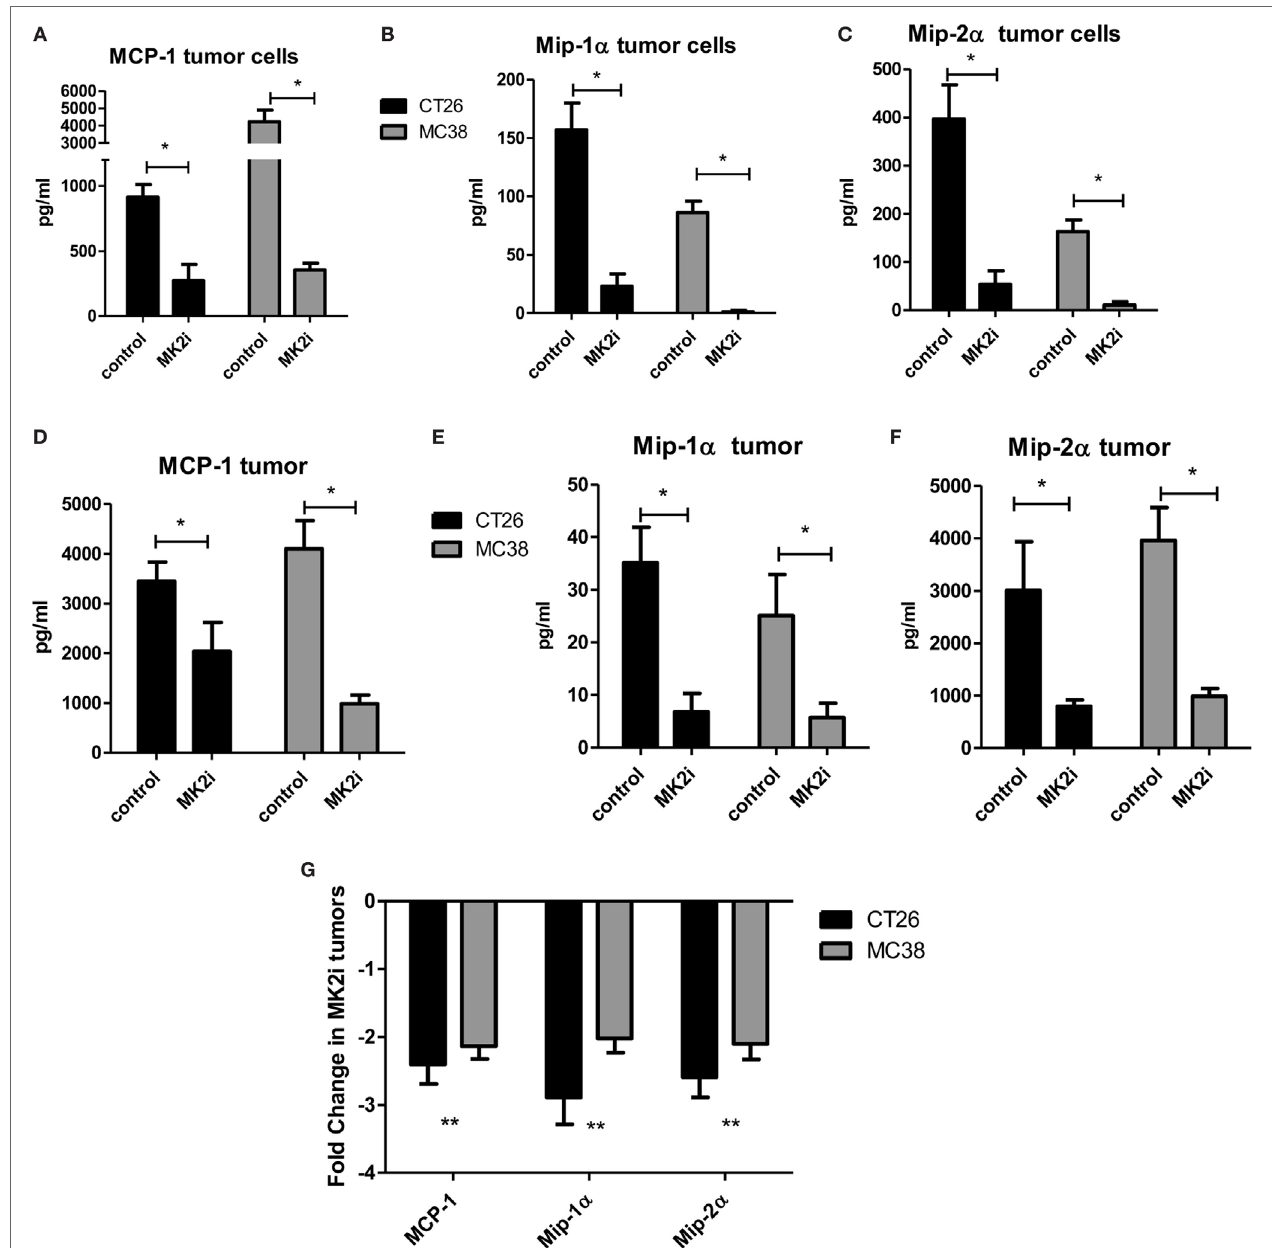
FigUre 1 | MK2 regulates colon cancer cell and colon tumor cytokine/chemokine production. CT26 and MC38 colorectal cancer cells in culture for 24 h produce (a) MCP-1, (B) Mip-1 α , and (c) Mip-2 α , which are drastically decreased upon MK2 inhibitor treatment (MK2i) as shown by multiplex bead array. Tumors developed from these cells in mice for 13 days show similar production of (D) MCP-1, (e) Mip-1 α , and (F) Mip-2 α when incubated overnight in media, which are also decreased with MK2i treatment. (g) MK2i-treated tumors also show a decrease in mRNA levels of these cytokines compared with control tumors. N = 6 for cultured tumor cells and 7–8 for tumors from multiple experiments, * p ≤ 0.05, ** p ≤ 0.01, and *** p ≤